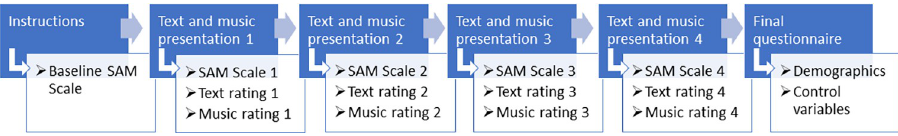
music ratings. Participants were randomly assigned to the ‘text first’ or ‘music first’